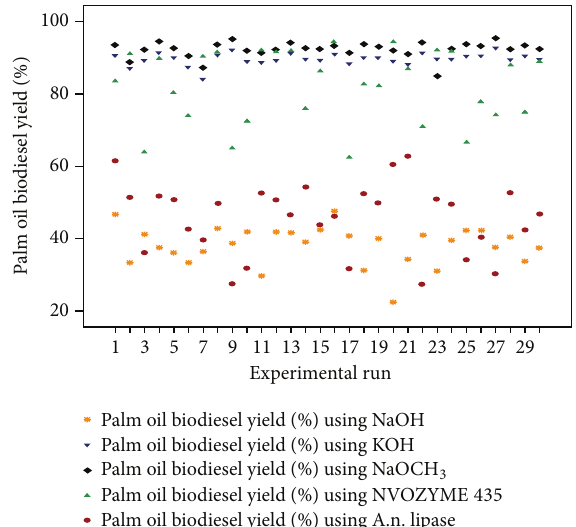
Figure 1: Comparative description of biodiesel yields (%) resulted from 30 experiments executed under reaction conditions defined by CCRD for chemical and enzymatic transesterification of palm oil.